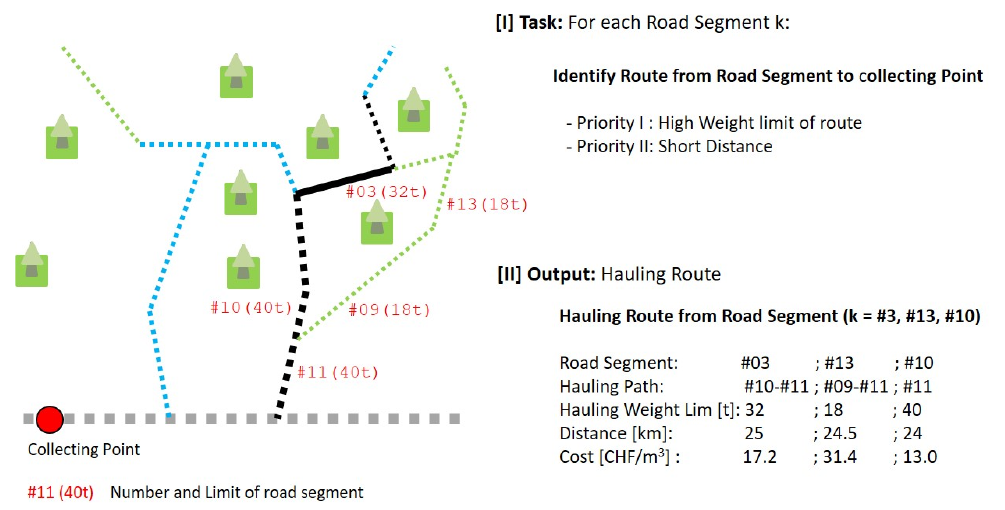
Figure 3. Task and output of the model subsystem “hauling route”. The “best” path to the collecting point for each road segment is